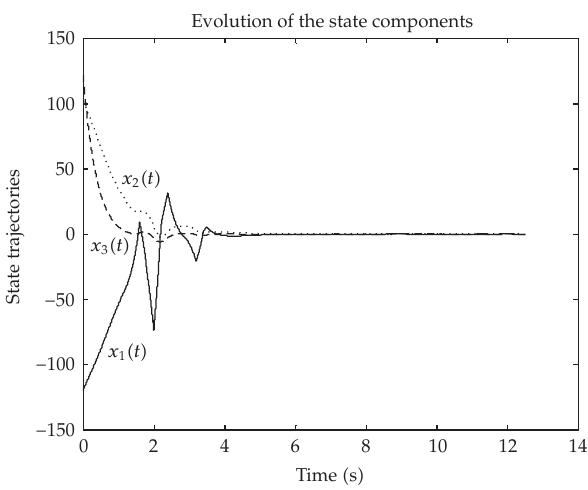
Figure 8: Evolution of the state-space components for h (cid:8) 0 . 4